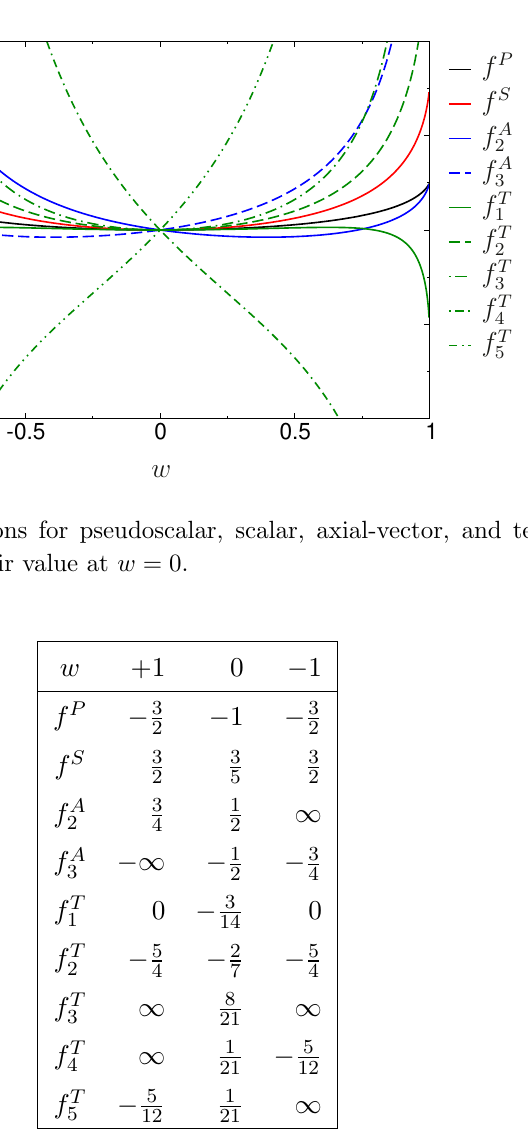
1. Note that none of the singularities (cid:6)